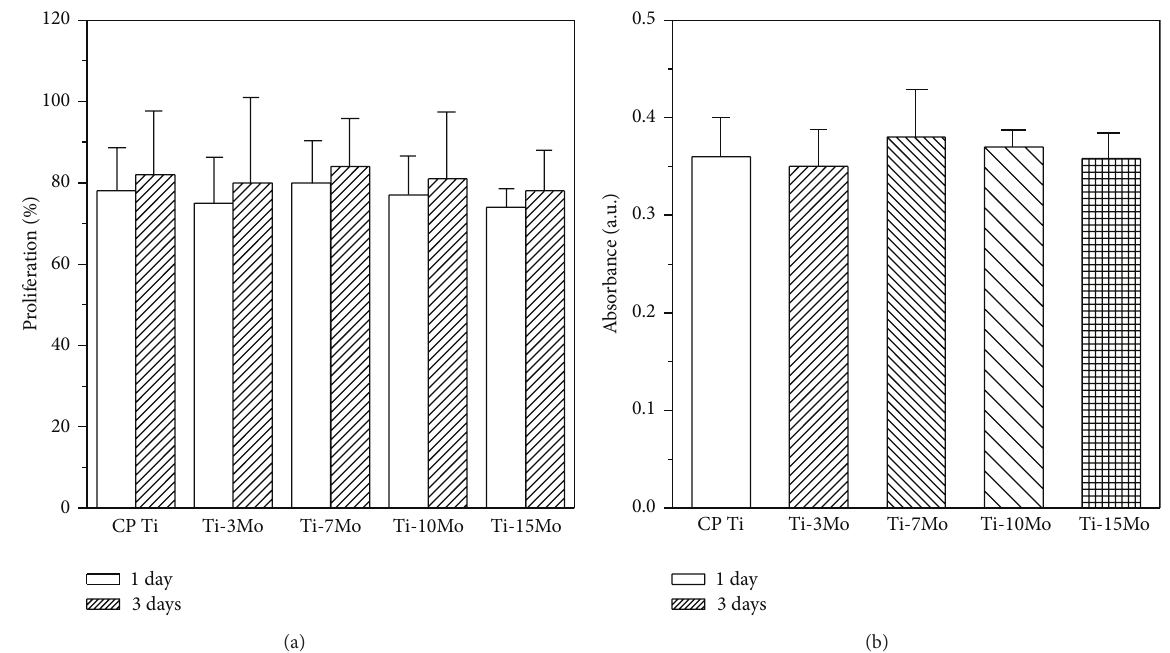
Figure 7: Cell proliferation tested with MC3T3-E1 osteoblasts after 1 day and 3 days of